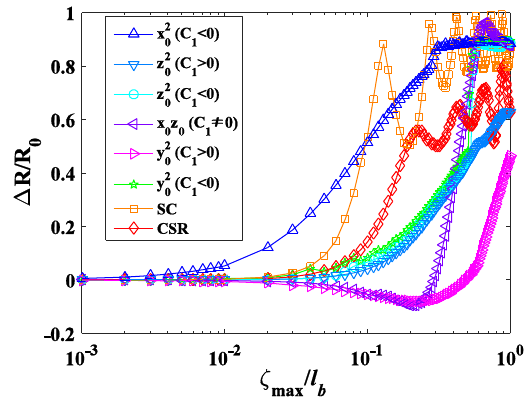
FIG. 8. The relative change of the transformer ratio versus the ratio of the maximum deviation ( ζ ( l b ) for each of the perturbation